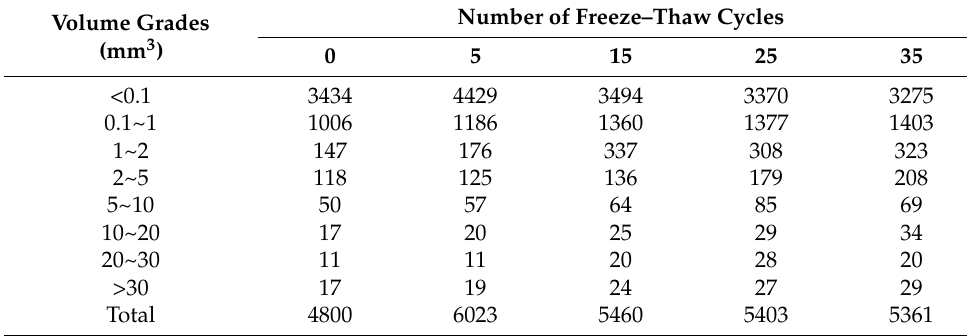
Table 7. Design voids content =